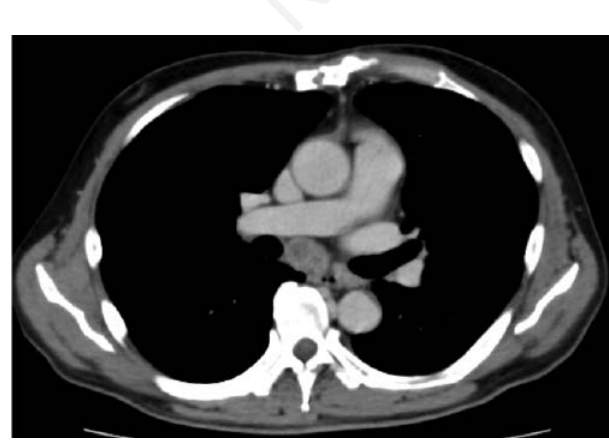
Figure 2. Caseous granuloma including multinucleated giant cell, indicating tuberculosis. Hematoxylin eosin stain, original magni- fication